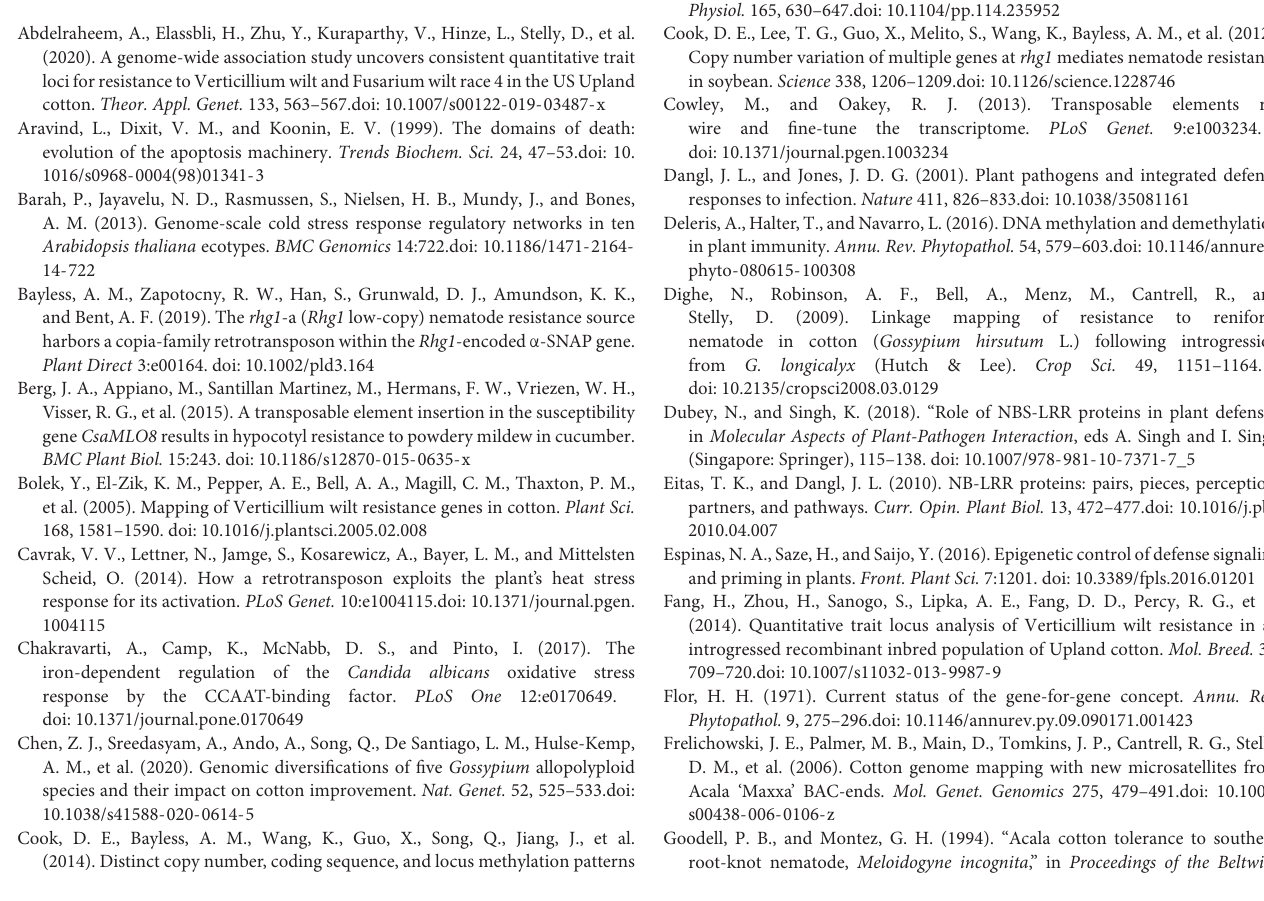
Supplementary Figure 9 | Comparison of protein kinase domain in the rkn1 region between Chr 11-BNL2650 and Chr 21-DC4031. Supplementary Tables 1, 2 | Chr11 (S1) and Chr 21 (S2) BAC mapping to Gossypium hirsutum TM-1 genome (https://www.cottongen.org/analysis/189)., Supplementary Tables 7–12 | Predicted genes, coding sequences (CDS), and peptides on Chr 11 (S7–S9) and Chr 21 (S10–12) BACs. Supplementary Tables 13–20 | Gene annotation on Chr 11 BACs, including GO (S13), GO summary tree (S14), Nr (S15), SwissProt (S16), COG (S17), KOG (S18), TrEMBL (S19), and Pfam (S20). TrEMBL (S27), and Pfam (S28). Supplementary Table 29 | The coding sequence comparisons of transposable elements and relative reverse transcriptase among N901 BACs and 4 Maxxa BACs (31K15, AC190836, AC202830, AC187810). Supplementary Tables 30–32 | The alignment of Chr 11 BACs to Gossypium arboreum A2 (S30), G. raimondii D5 (S31), and G. barbadense AD2